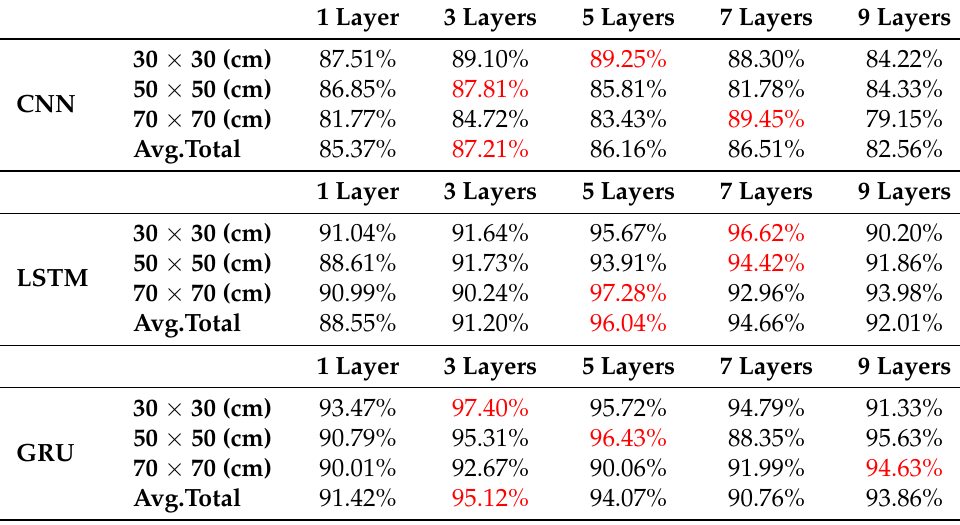
Figure 14. Graphs of the loss function. ( a ) is Graphs of the CNN loss function, ( b ) is Graphs of the LSTM loss function and ( c ) is Graphs of the GRU loss function Tables 1–3 are performance comparisons for each layer depth of the CNN, LSTM and GRU. The performance of each layer was compared according to the distance between the steel plate and the sensor. Table 1. 30 cm distance between the steel plate and sensor. Red is the best